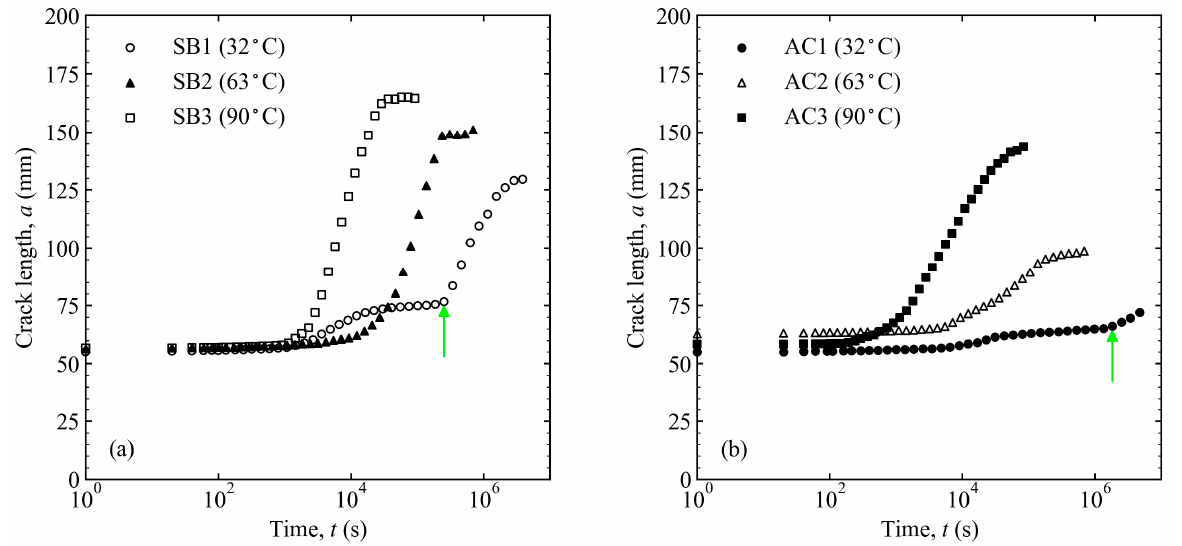
Figure 9. Crack length variation over time at different temperatures and surface treatments: ( a ) sand-